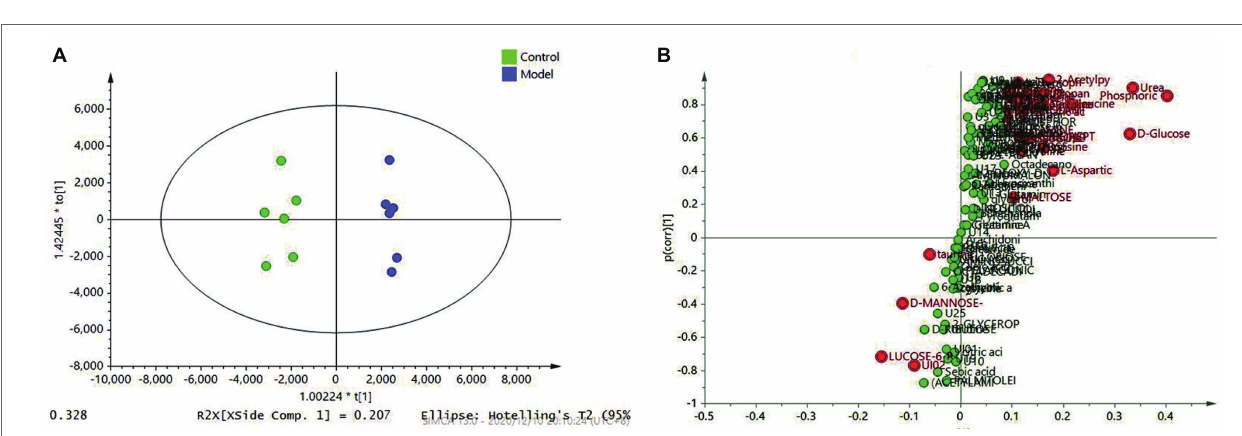
FIGURE 4 | The Partial Least-Squares Discriminant Analysis (PLS-DA) scores plot of the HAMI model rats and the rats treated. The green plots are the control group; the blue plots are the l -carnitine group (L); the red plots are the trimetazidine group (T); the yellow plots are the LT group; and the purple plots are the HAMI model group.